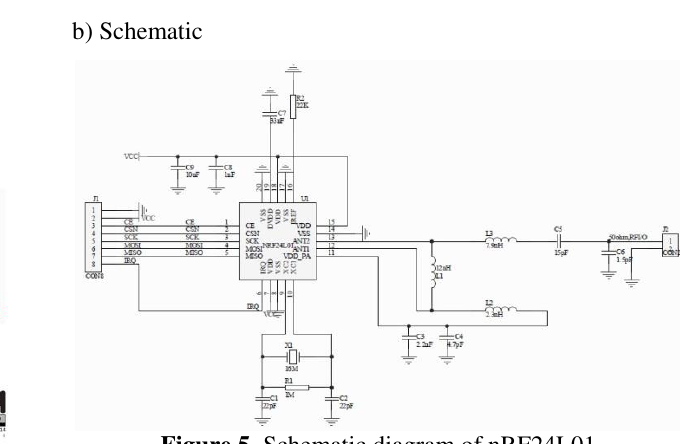
Figure 5. Schematic diagram of nRF24L01